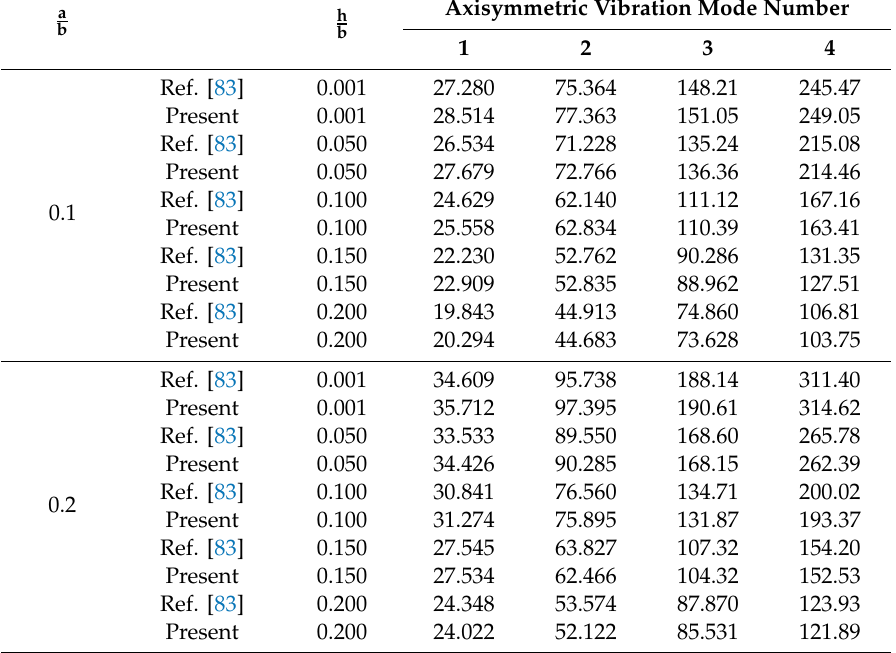
Table 4. Comparison of nondimensional natural frequency of the annular plate for di ff erent axisymmetric vibration mode number, inner radius to outer radius ratio, and thickness to outer radius ratio for clamp-clamp boundary